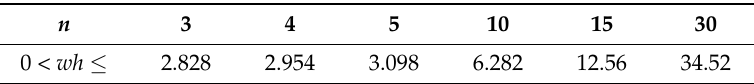
Figure 1. Spectral radii for different n of the improved DQTEM (Differential Quadrature Time Finite Element Method). Table 2. The first stable intervals with ρ ( J ) = 1 for different n .